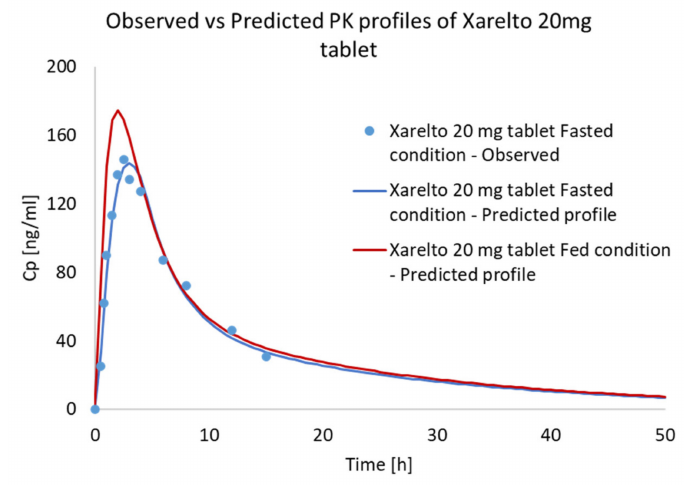
Figure 12. Predicted mean in vivo profiles of Xarelto 20 mg tablet using IVIVC